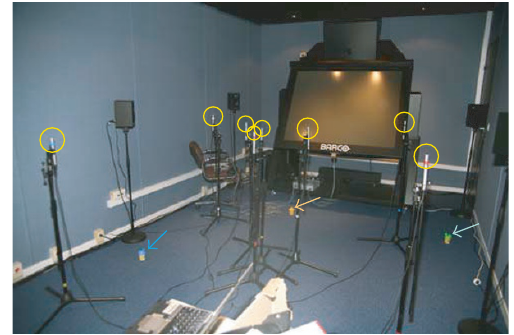
Figure 7: Indoor validation setup using 8 microphones. The 3 markers (see blue, yellow, green arrows) on the ground correspond to the location of the recorded speech signals.